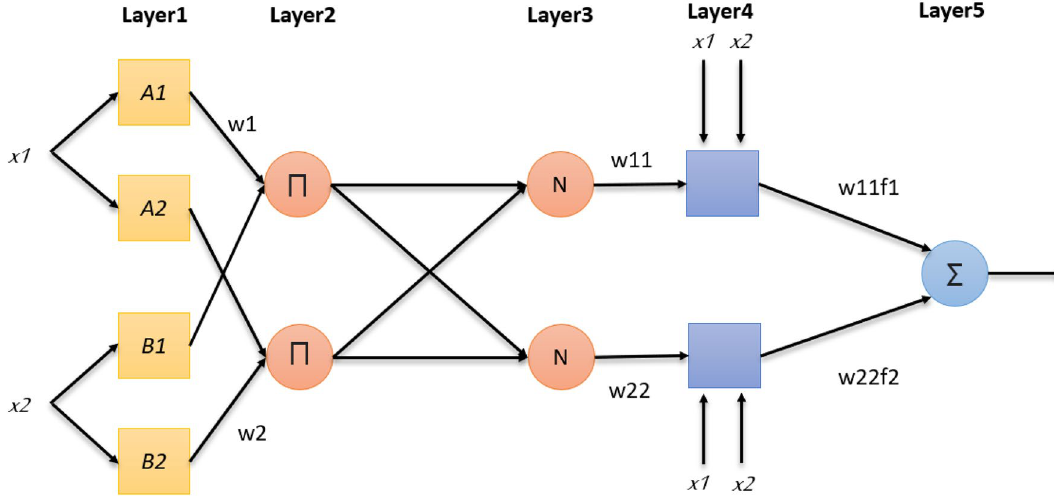
Figure 2. The structure of 2 inputs parameters of